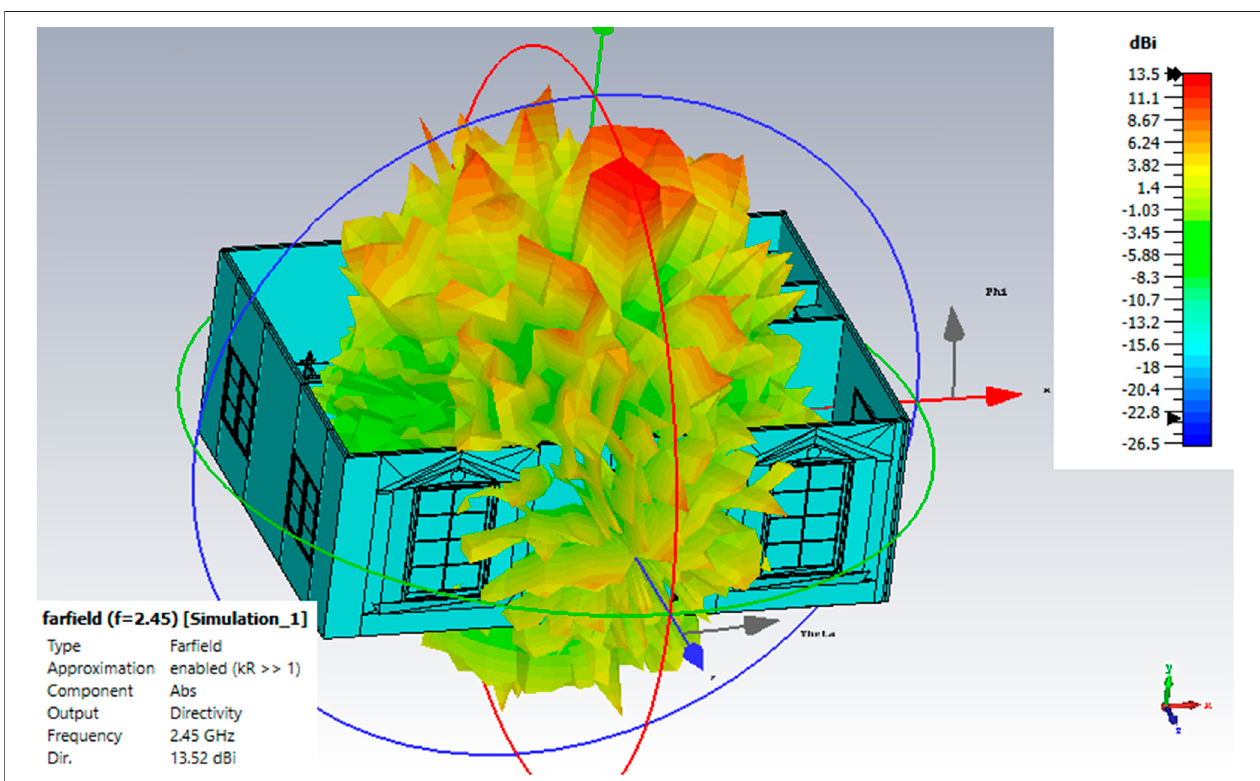
FIGURE 13 | Radiation pattern for wireless